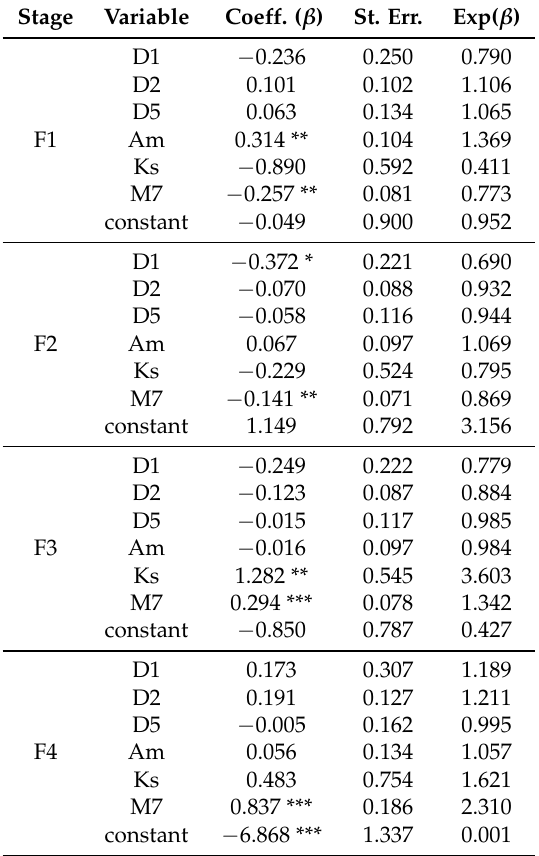
Table 6. The final results of logit regression model for all stages F1–F4 (block 3 in step 3).